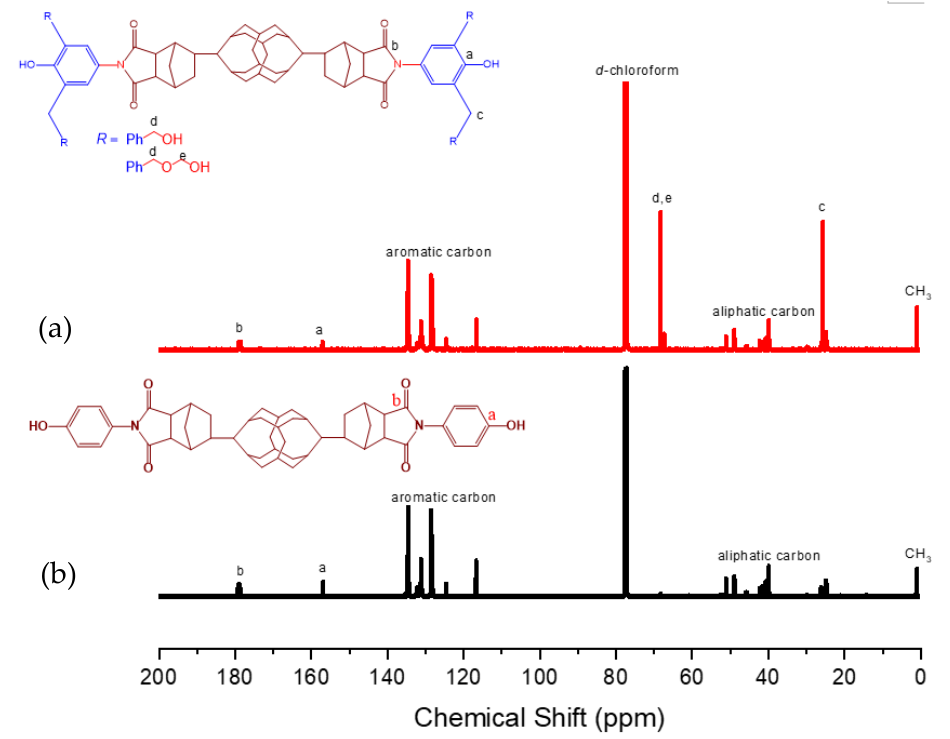
Figure 2. 13 C NMR spectra of ( a ) DDSQ-4OH and ( b ) pure PDDSQ.